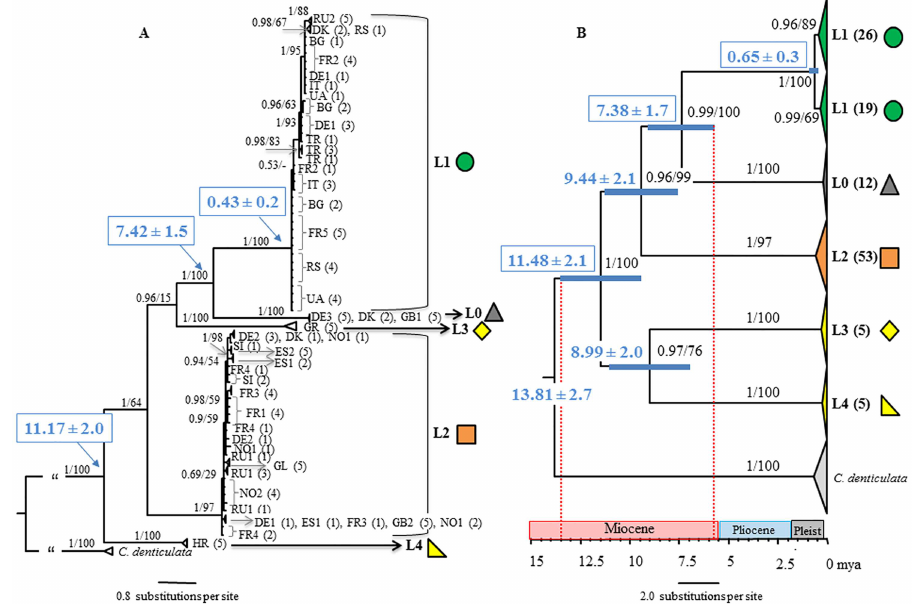
Fig 2. Phylogenetic relationships and molecular divergence estimatesof five European lineages of Parisotoma notabilis . A Bayesianphylogeny basedon nucleotidesequencedata of three genes (28Sr DNA, H3 and COI), blue values in boxes are divergence estimates basedon the combinedmatrix calculatedwith BEAST (see also S3 Fig). B Molecularclock tree basedon COI sequences(709 bp) calculatedwith BEAST. Blue bars on nodesrepresent 95% confidence intervals. Bold numbers on nodesare divergence times with confidenceintervals in mya. A geologicaltimescale is providedbelowthe tree, indicating the Miocene(23–5.3 mya), the Pliocene (5.3–1.8 mya) and the Pleistocene (Pleist. 1.8–0.0114 mya). Dashedred lines indicate radiationsof major lineagesduringthe Miocene.Terminal clades are collapsed; numbersin brackets indicate the numbers of individuals of each samplinglocations includedin the respectiveclades. Numbers on nodes are posterior probabilities (BayesianInference) and bootstrap values (Maximum